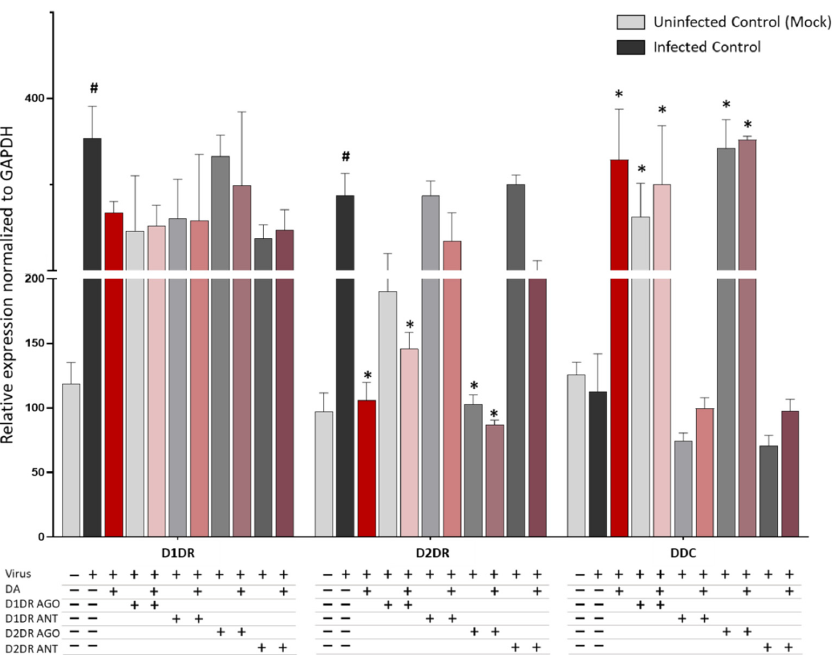
Figure 4. D1 and D2 receptor agonist/antagonist-induced changes in the expression of D1DR, D2DR, and DDC. Similar to DA 50 μ M, administration of DR agonists (10 μ M) to SARS-CoV-2-Infected cells, either alone or in combination with DA, decreases the expression of D2DR while increasing the expression of DDC compared with SARS-CoV-2-Infected Control at 48h post-infection. The most robust effects are produced by D2DR agonists either alone or in combination with DA. mRNA quantification was performed through real-time qPCR and calculated by the 2 −ΔΔ Ct equation. Results are presented as mean ± SEM from at least n = 3 independent experiments, each performed in triplicate. # p < 0.05 vs. Uninfected Control (Mock), * p < 0.05 vs. SARS-CoV-2-Infected Control. events [22–24], namely (i) inhibition of mRNA receptor transcription, (ii) reduction in the receptor mRNA steady-state levels, (iii) post-transcriptional agonist-mediated